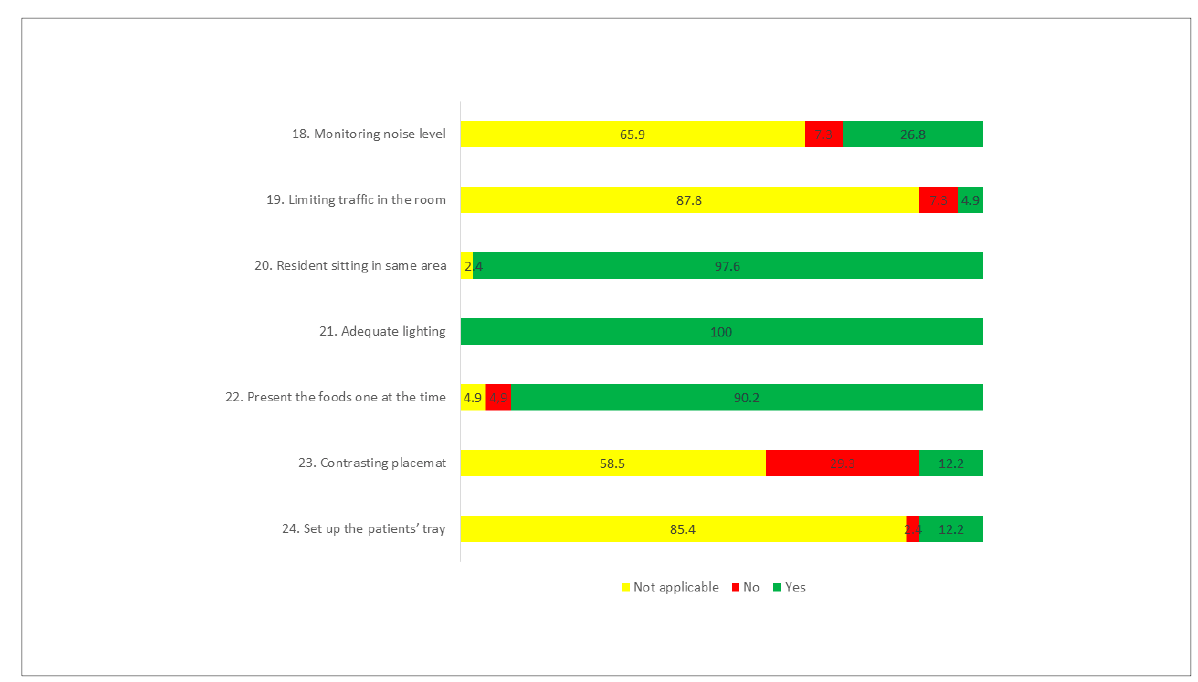
Figure 3. Actions performed (%)—Environment dimension.